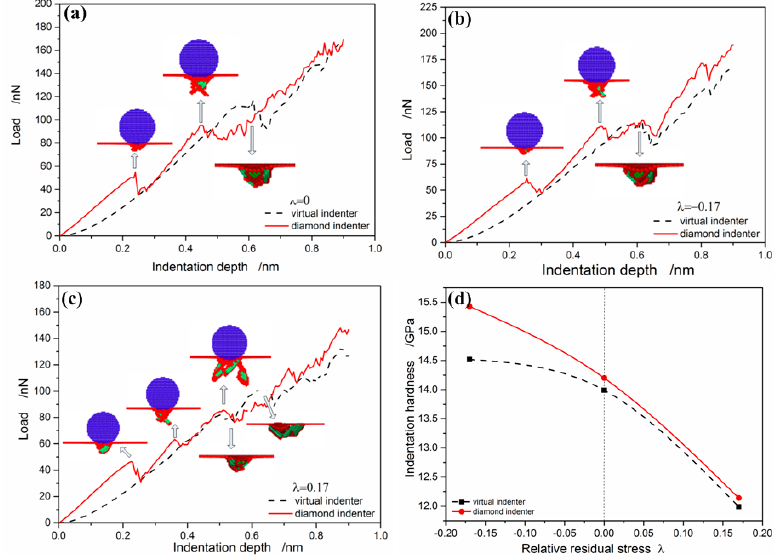
Figure 15. Comparison of indentation results of realistic and virtual sphere indenters. ( a ) without residual stress, ( b ) under compressive residual stress, ( c ) under tensile residual stress, ( d ) hardness vs. residual stress.